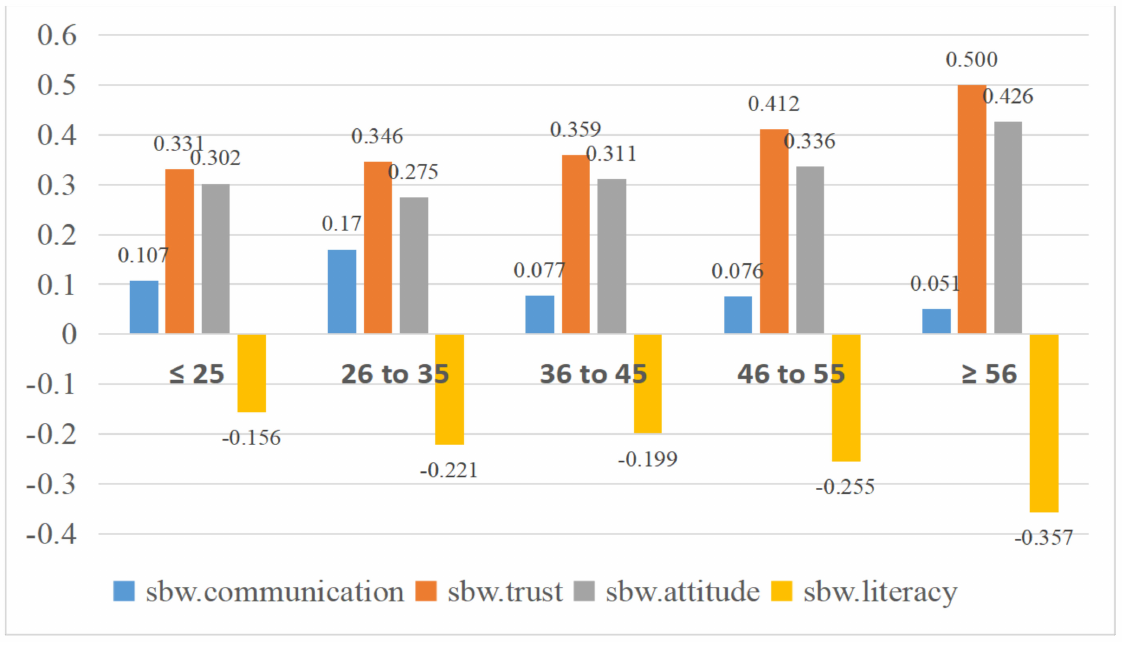
Figure A2. The best-worst scores for respondents of different ages on four statistically significant factors (SBW, standardized best-worst score).